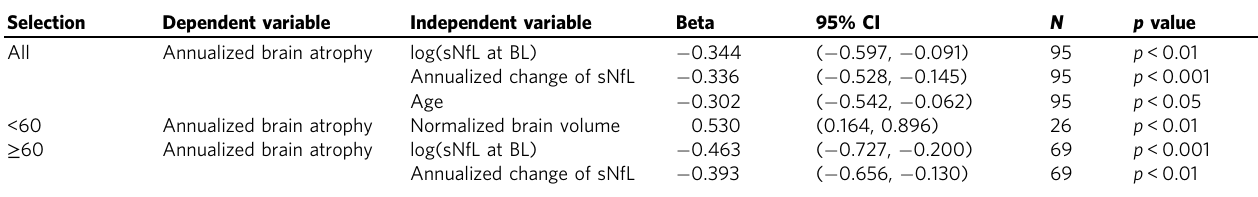
Table 5 Results of the stepwise regression to identify the main determinants of brain atrophy.